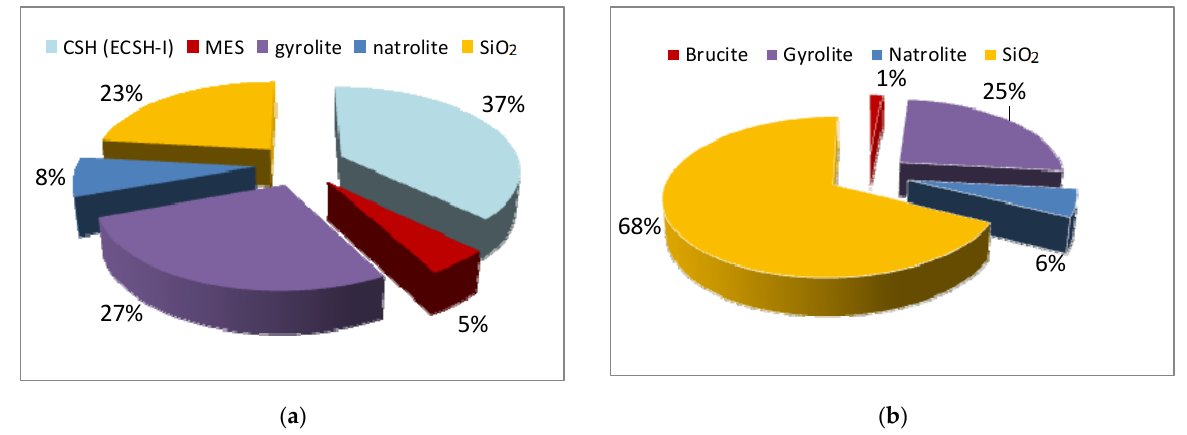
Figure 28. ( a ) Volume% of solids predicted by thermodynamic simulation at 25 °C, 1 bar. ( b ) Volume% of solids predicted by thermodynamic simulation at 25 °C, 1 bar. In this simulation, precipitation of C ‐ S ‐ H (ECSH ‐ I) was suppressed.